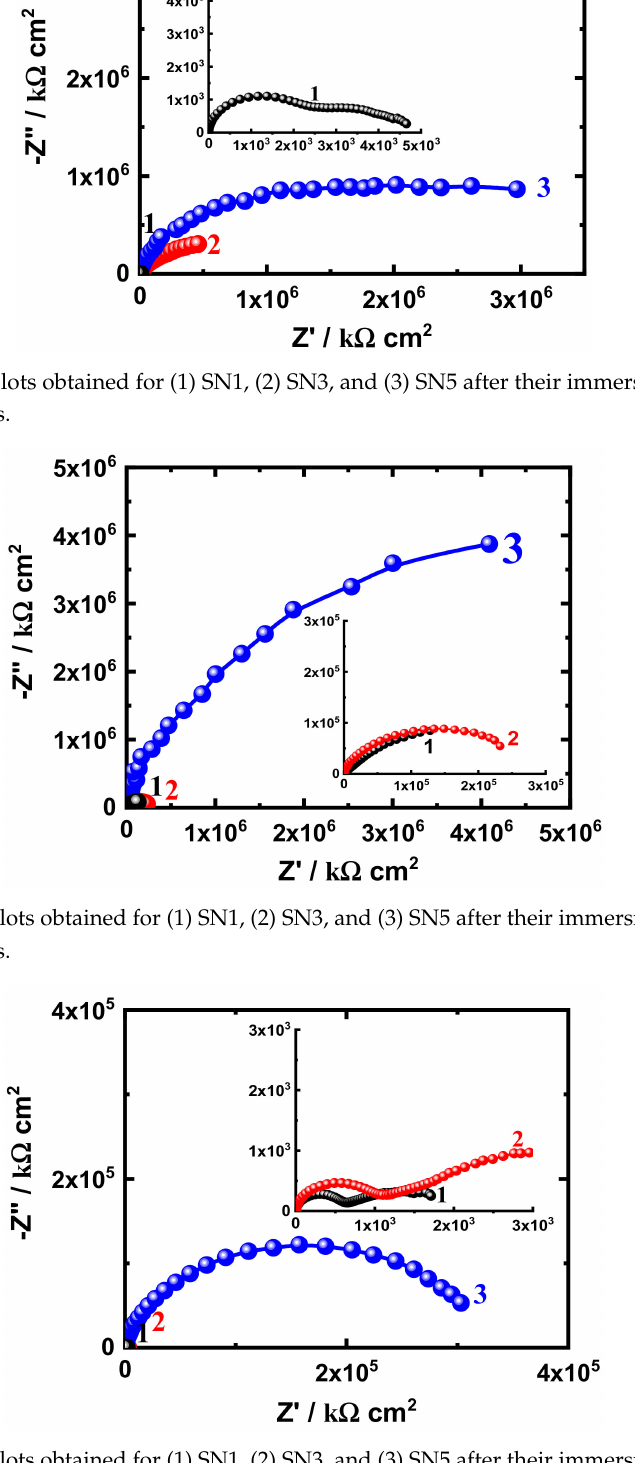
Figure 8. Nyquist plots obtained for (1) SN1, (2) SN3, and (3) SN5 after their immersion for 15 days in 3.5% NaCl